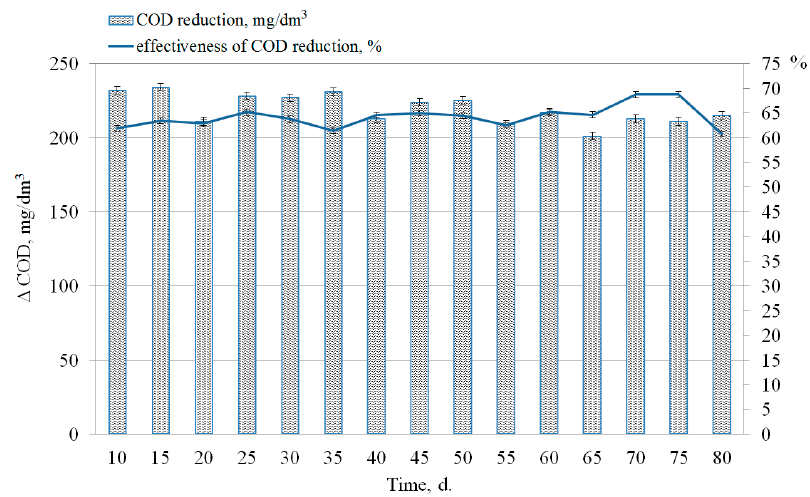
Figure 11. Determination of the level of COD reduction after anaerobic conversion of sewage sludge and phosphogypsum.